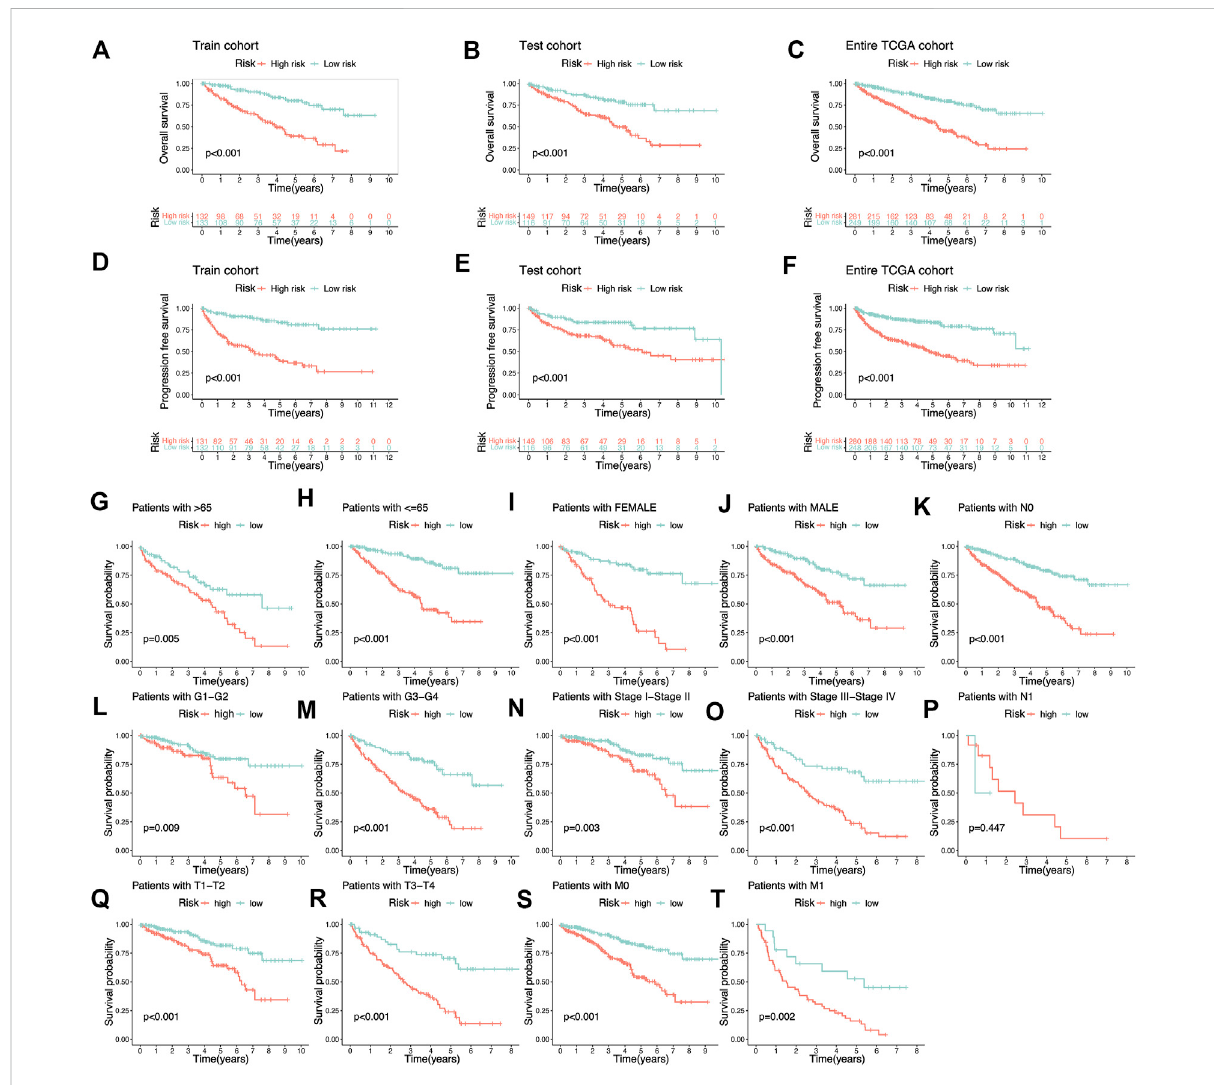
FIGURE 4 K-Msurvivalanalysisbasedoncuproptosis-relatedlncRNAsrisksignature. (A – C) TheOverallsurvivalK-Msurvivalcurvesofdifferentriskgroups in Train cohort, Test cohort, and Entire TCGA cohort. The overall survival of patients with high-risk KIRC is lower than that of patients with low-risk KIRC. (D – F) The Progression-free survival K-M survival curves of different risk groups in Train cohort, Test cohort, and Entire TCGA cohort. The Progression-freesurvivalofpatientswithhigh-riskKIRCislowerthanthatofpatientswithlow-riskKIRC. (G – T) TheOverallsurvivalK-Msurvival curves of different risk groups with different clinical